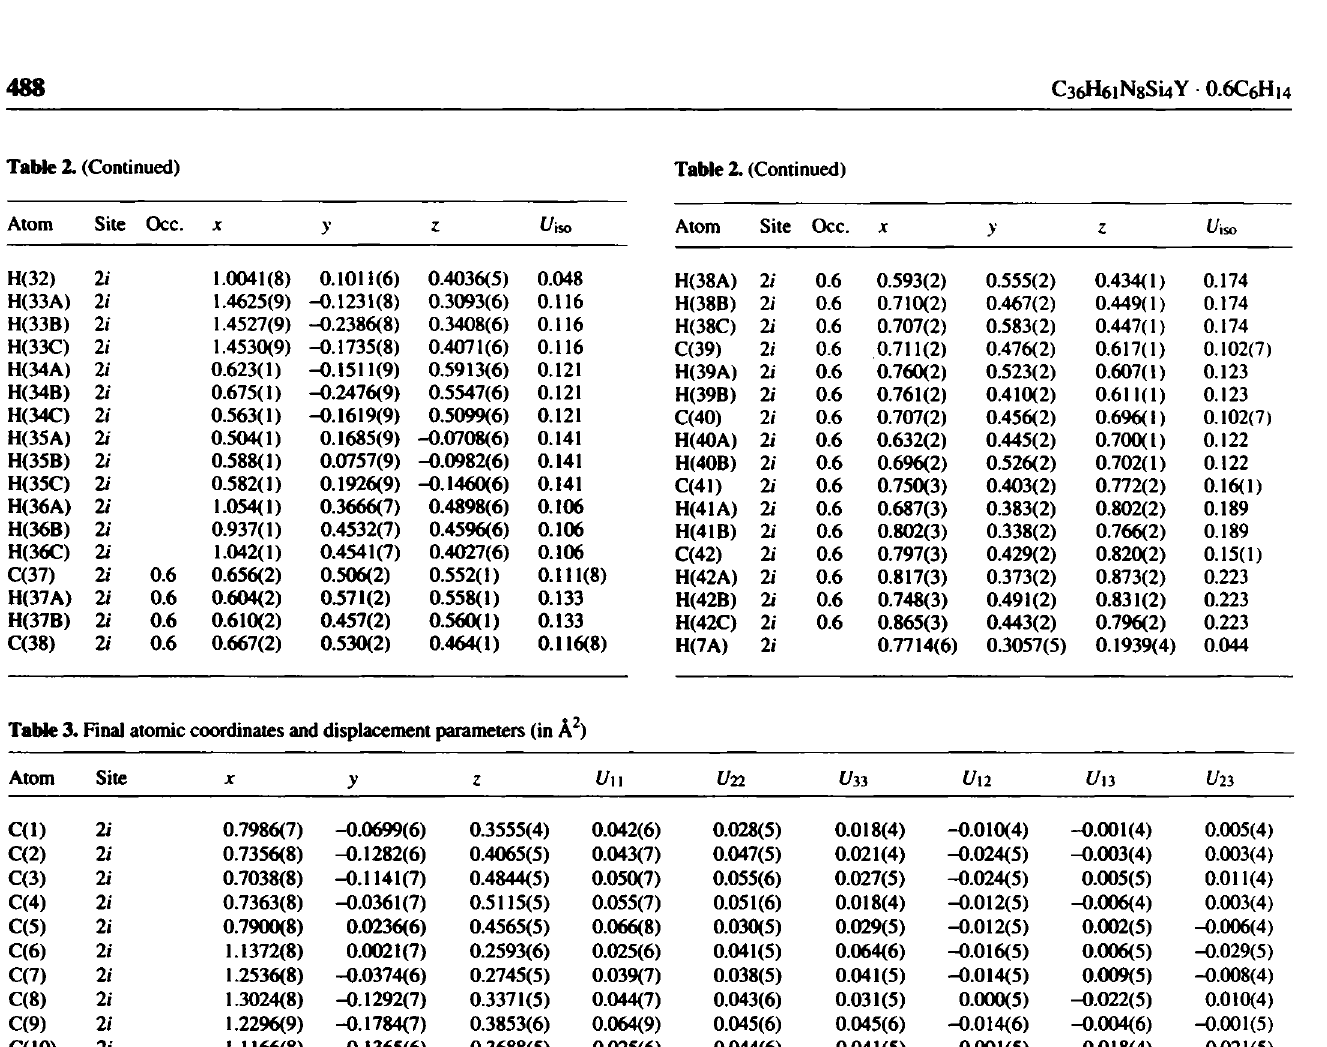
Table 3. Final atomic coordinates and displacement parameters (in Â 2